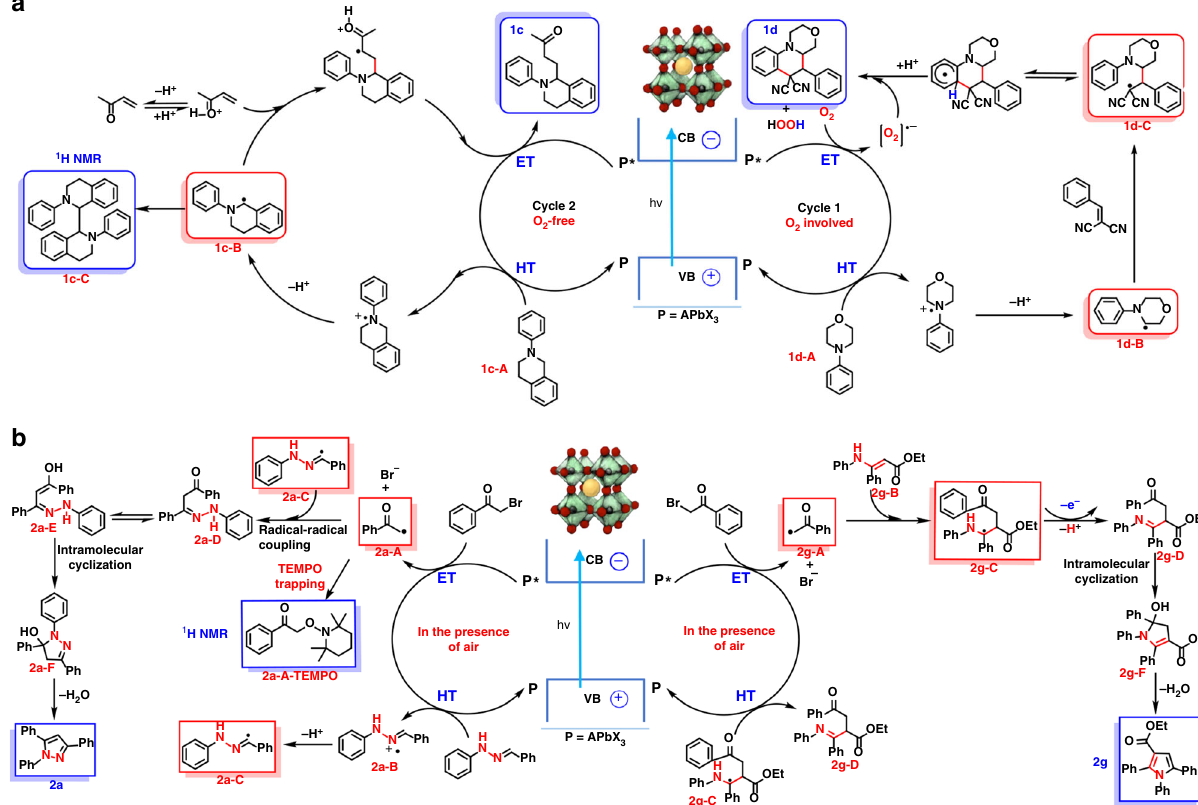
Fig. 3 Mechanisms. a Proposed mechanisms for the synthesis of 1c and 1d ; b 2a and 2g . (Blue square: isolated and characterized by 1 H-NMR; Red square: trapped and detected by LC-MS (Supplementary Figs. 18 – 23); HT = hole-transfer; ET = electron-transfer)